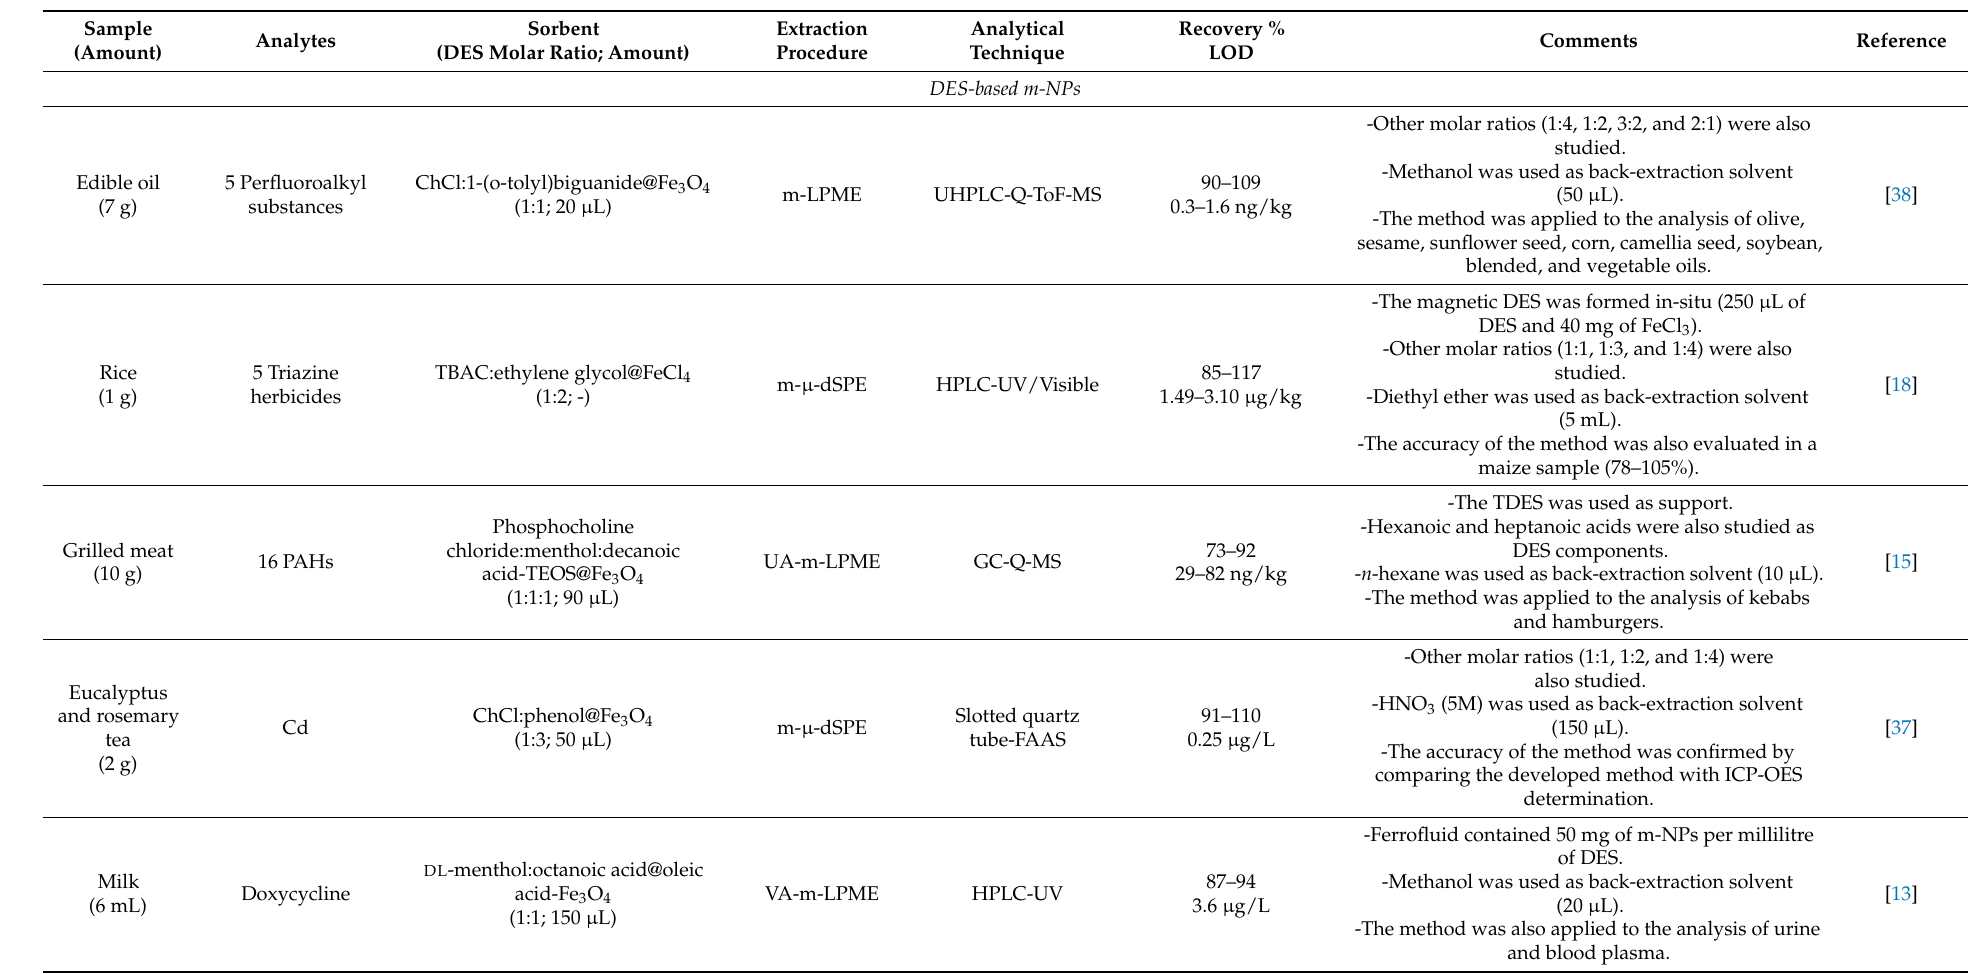
Table 1. Some examples of the application of innovative combinations of magnetic nanoparticles with DESs in food